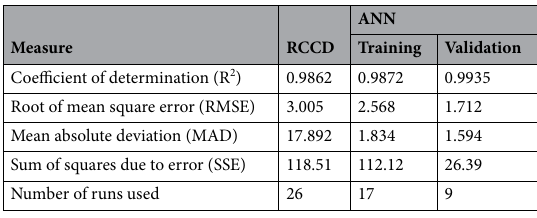
Table 6. Modeling comparison statistics of RCCD and ANN.